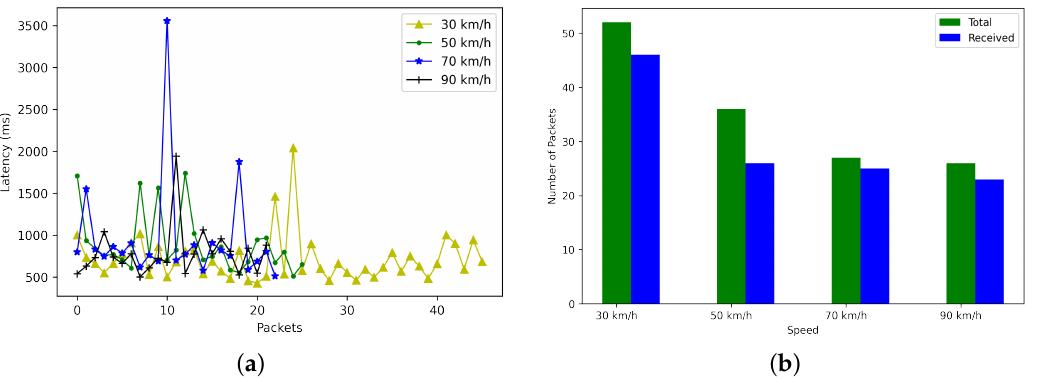
Figure 4. Obtained results. ( a ) End-to-end latency at different speeds. ( b ) Total packets sent versus packets